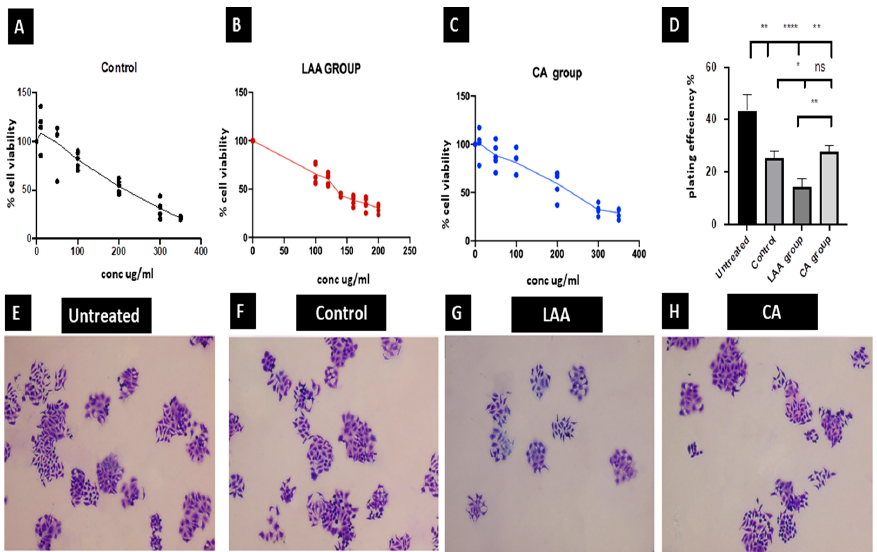
Figure 2. Cellular cytotoxicity ( A – C ); clonogenic assay statistical analysis of plating efficiency (PE) of tested groups blotted at the X axis, PE % = the number of colonies formed/number of cells plated) × 100 blotted at the Y axis, the untreated group showed the highest PE while the LAA group showed the least PE, being significantly lower than the CA, control and untreated groups. * Significance at p < 0.05, ** Significance at p < 0.001, **** Significance at p < 0.0001, ns No significant difference. ( D ) Clonogenic assay images showing cell colonies stained with crystal violet imaged using inverted light microscope X40 (Olympus CKX41SF, Tokyo, Japan) ( E – H ). Untreated ( E ); control ( A , F ); L-ascorbic acid ( B , G ); citric acid ( C , H ).